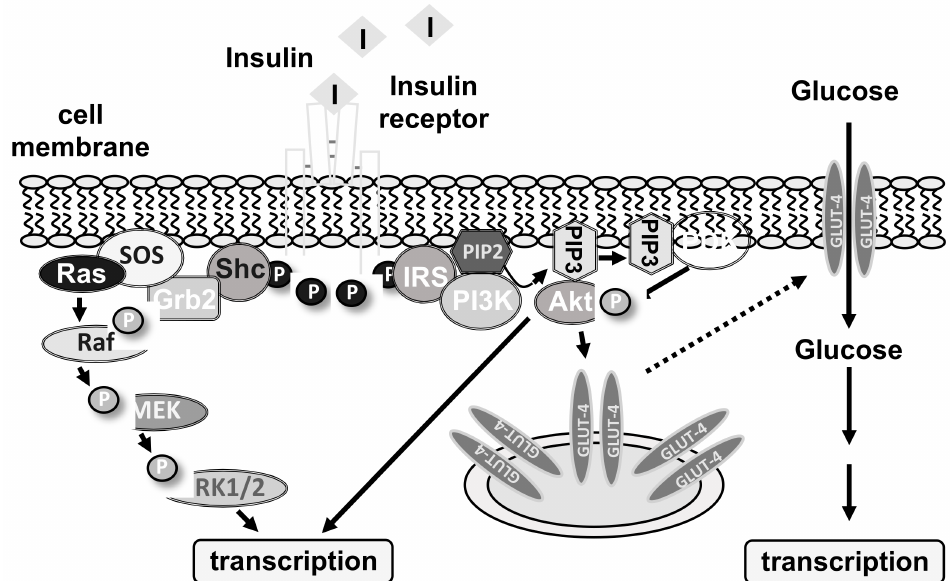
Figure 1. Insulin receptor signaling. This figure shows a schematic model of two kinase cascades activated by insulin receptor stimulation. Insulin binding to the insulin receptor triggers tyrosine phosphorylation of the receptor and the adapter proteins Shc and insulin receptor substrates (IRS). Shc binds to the adaptor protein Grb2 that interacts with the guanine nucleotide exchange factor SOS (son of sevenless), generating the activated GTP-bound protein Ras. This G protein binds and activates the protein kinase Raf that in turn phosphorylates the protein kinase MEK (Mitogen-activated protein kinase/extracellular signal-regulated protein kinase kinase). Finally, MEK phosphorylates and activates ERK1/2 (extracellular signal-regulated protein kinase). The second cascade involves the lipid kinase phosphatidylinositol 3-kinase (PI3 kinase) which binds with its p85 regulatory domain to phosphorylated IRS. This activates the catalytic subunit of PI3 kinase, which catalyzes the phosphorylation of phosphatidylinositol-4,5-bisphosphate (PIP2) to phosphatidylinositol-3,4,5- trisphosphate (PIP3). This phospholipid binds to the protein kinase B/Akt and 3-phosphoinositide- dependent protein kinase (PDK) and triggers their activation. The protein kinases ERK1/2 and protein kinase B/Akt function as signal transducers to transport the hormonal information into